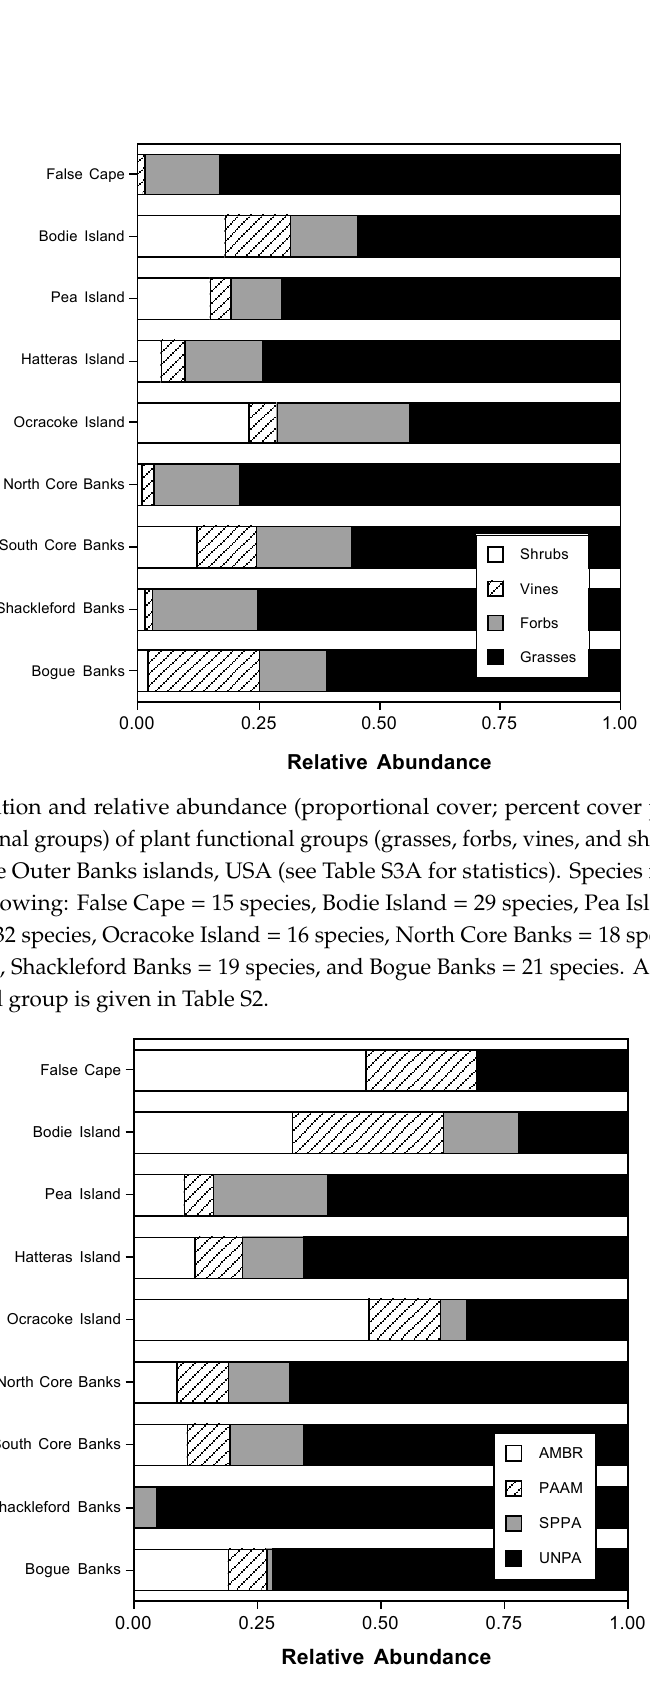
Figure 4. The distribution and relative abundance (proportional shoot density; number of shoots per total number of shoots for all dune grass species) of the dominant dune grass species (AMBR = Ammophila breviligulata , PAAM = Panicum amarum , SPPA = Spartina patens , UNPA = Uniola paniculata ) found in the foredunes of the Outer Banks islands, USA (see Table S3B for statistics). Of the foredunes where all the four dune grass species were present, species varied in their abundance along the cross-shore profile (Figure 5, Table S3C). Uniola paniculata and A. breviligulata were co-dominants at the foredune toe/face and U. paniculata was dominant at the foredune crest. Spartina patens was most abundant at the foredune back/heel, where it was co-dominant with U. paniculata . Panicum amarum had relatively low abundance across the profile. Figure 5. The distribution and relative abundance (proportional shoot density; number of shoots per total number of shoots for all dune grass species) of the dominant dune grass species (abbreviations in Figure 4) found along cross-shore profiles of foredunes that included all dune grass species within the Outer Banks islands, USA (see Table S3C for statistics). 3.2. Dune Grass Growth Form and Morphology and Changes in Sand Elevation